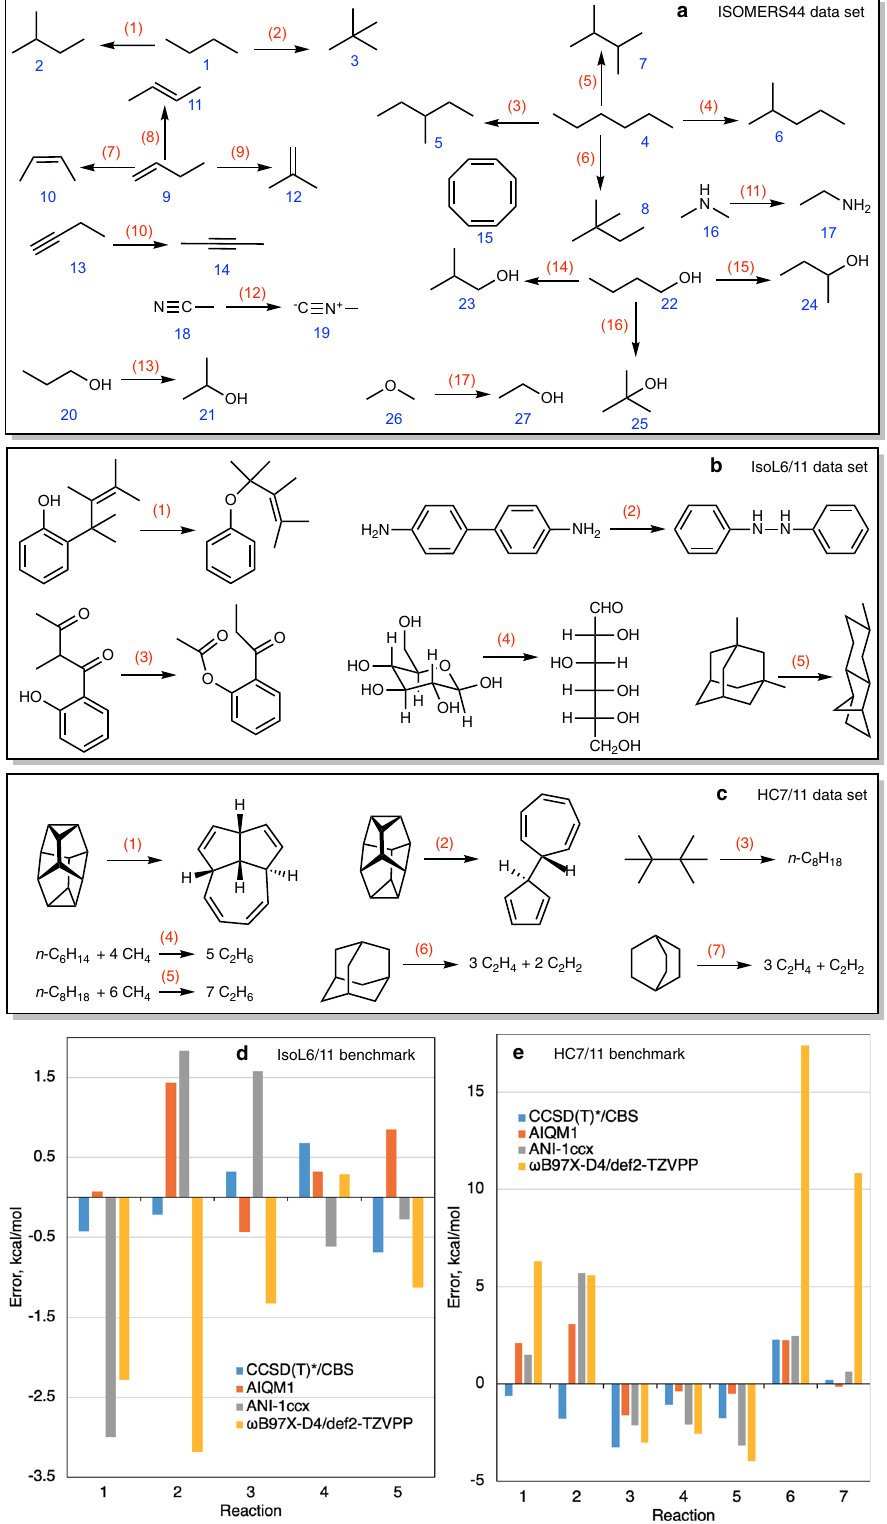
Fig. 5 Selection of data sets for testing performance of the arti fi cial intelligence – quantum mechanical method 1 (AIQM1) for ground-state energies. a ISOMERS44 set for testing accuracy in predicting heats of formation for 27 molecules (blue numbers) and 17 reaction enthalpies (red numbers), b reactions in IsoL6/11 set used to test accuracy in isomerization energies, c reactions in HC7/11 set used to test relative energies. Comparison between errors of CCSD(T)*/CBS, AIQM1, ANI-1ccx, and ω B97X-D4/def2-TZVPP for the reaction energies in the d IsoL6/11 and e HC7/11 benchmark